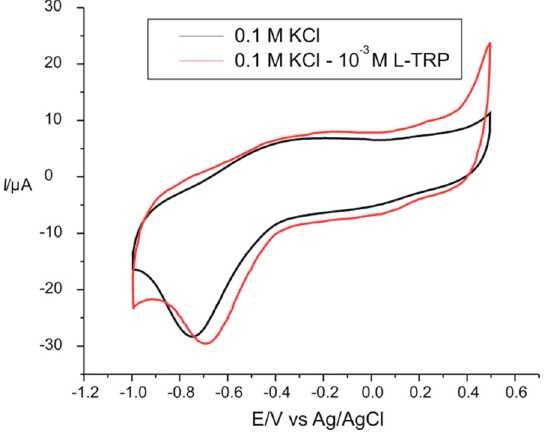
Figure 5. Electrochemical response of PPy/FeCN sensor immersed in a 0.1 M KCl solution (black